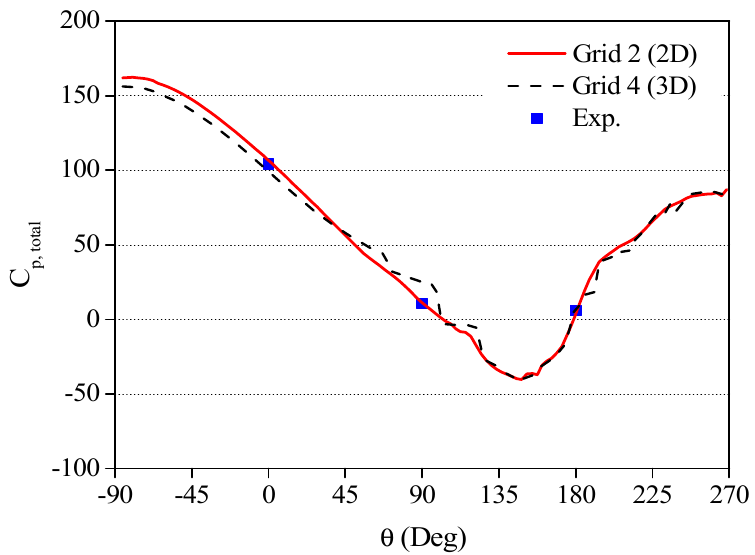
Figure 5. Comparison of measured and predicted pressure coefficients on the surface of the circular dam for the validation case (Case A1).